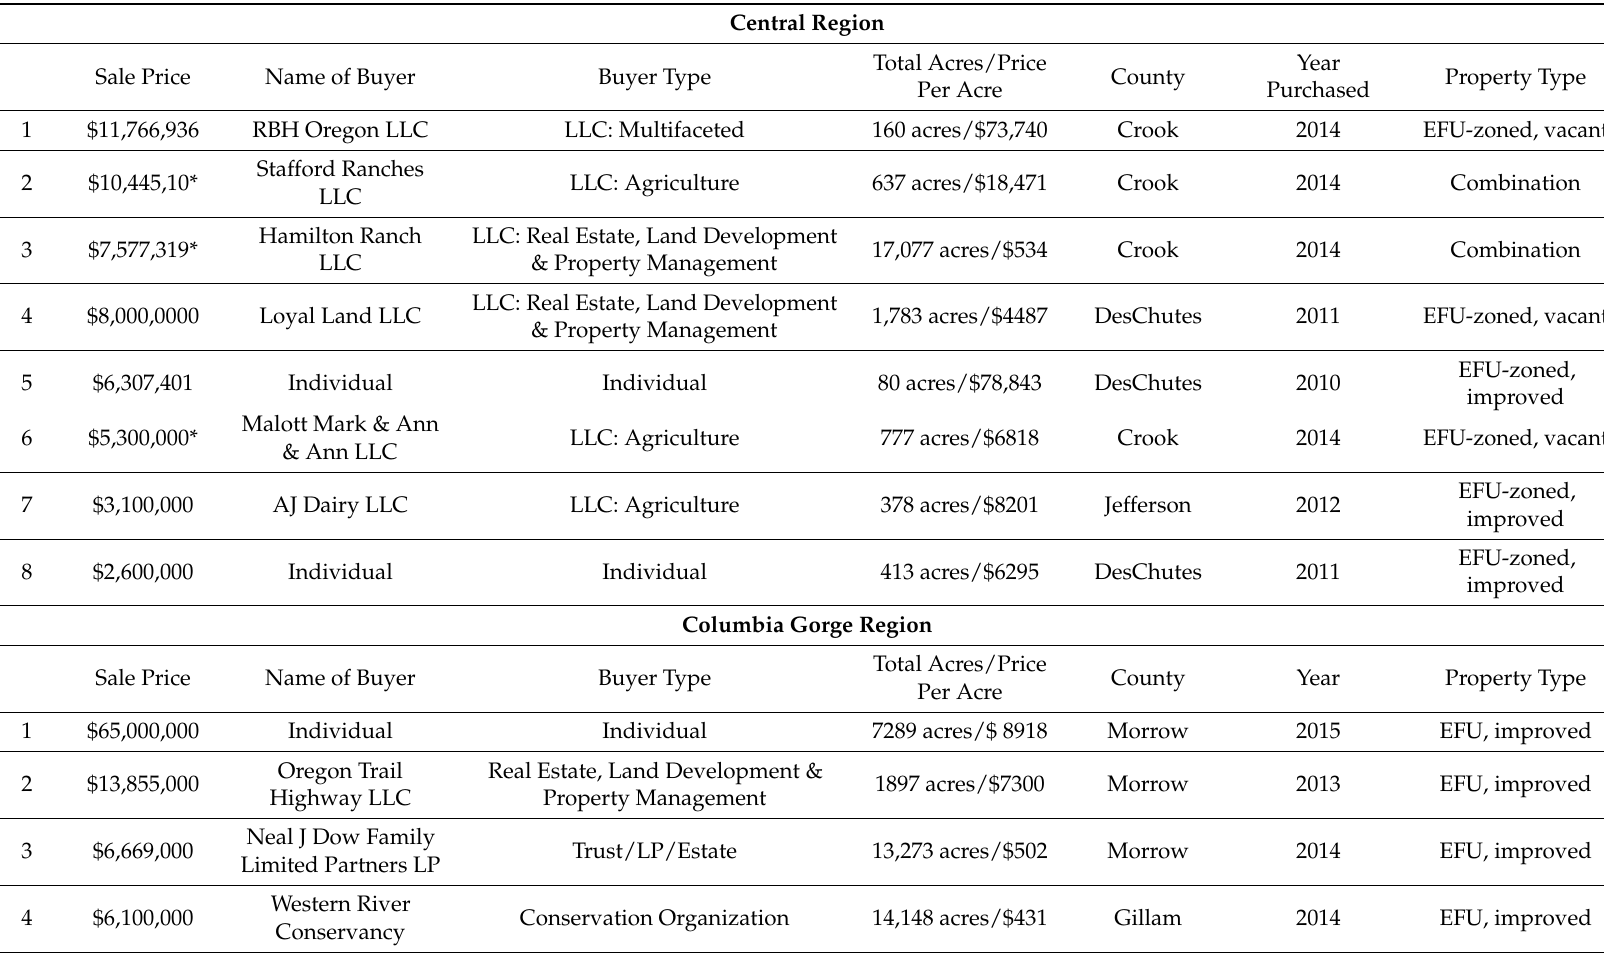
Table 2. Top ten purchases by price (2010–2015). Central